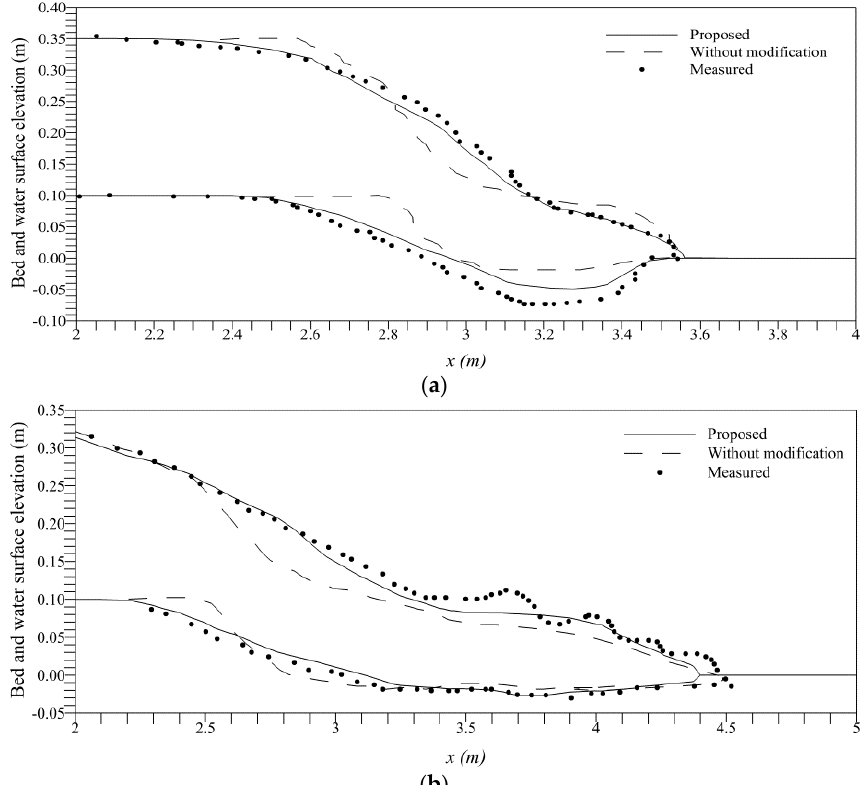
Figure 7. Cont. Figure 7.